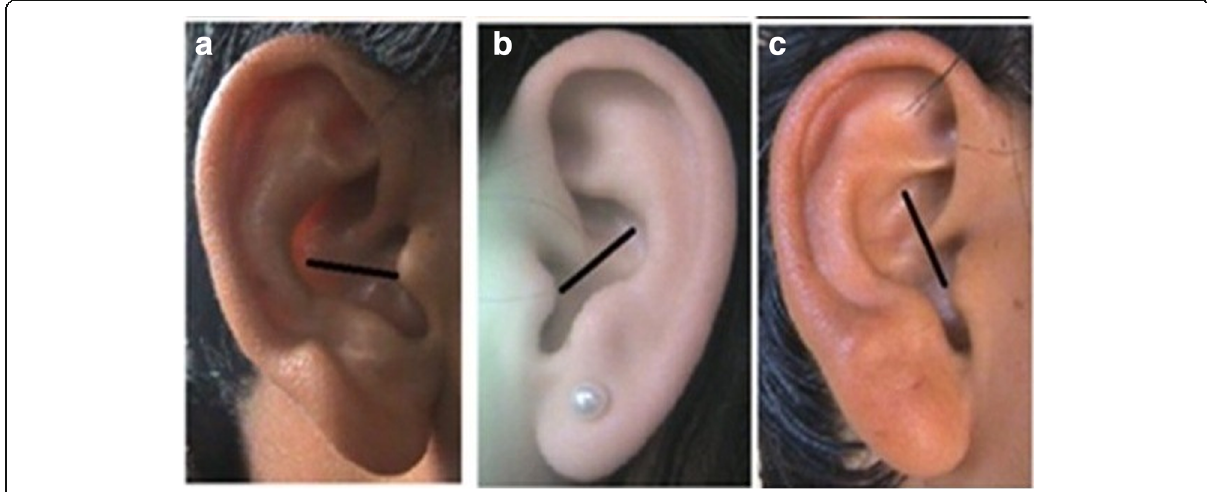
Fig. 7 Photographs showing the different shapes of the ear tragus. a Knob. b Round. c Long